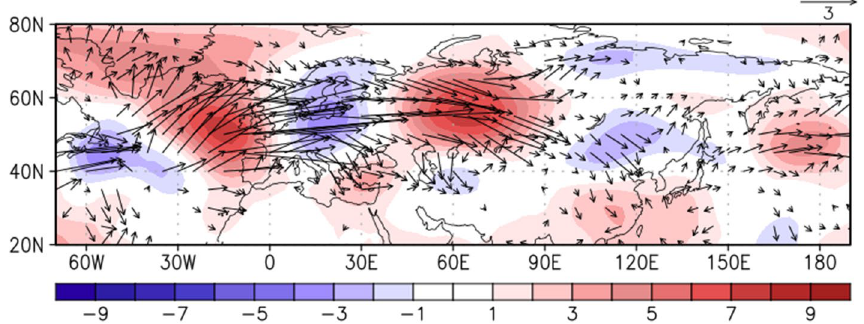
6 m 2 s − 2 ) anomalies at 300 hPa and related wave activity flux